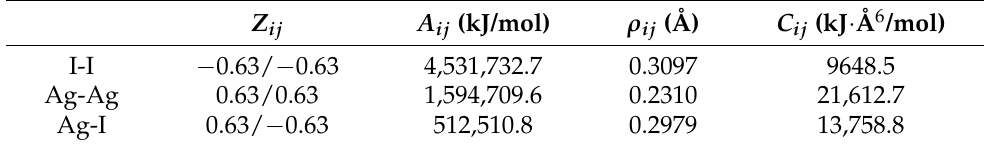
Table 1. Values of adjustment parameters for pair potential (1).